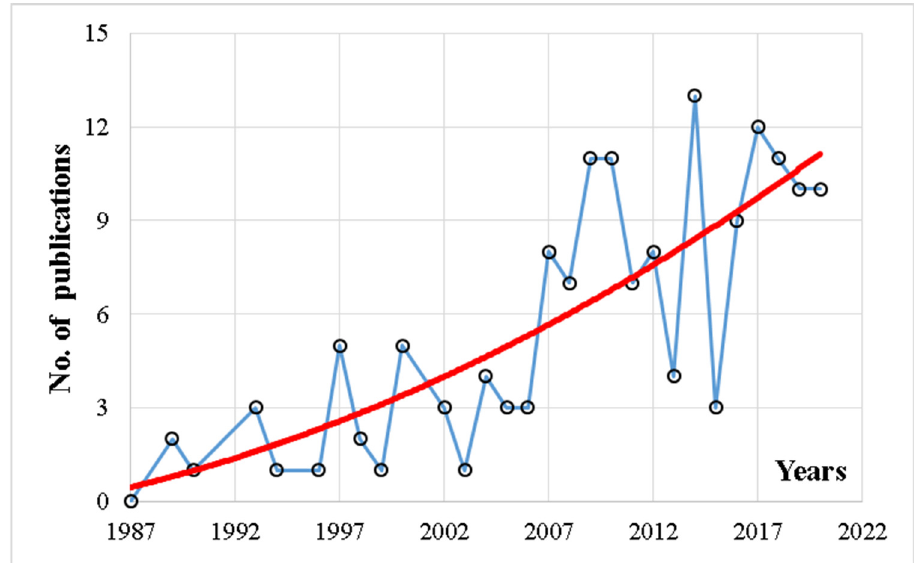
Figure 14. Publishing rate of infrastructure research using AI techniques.